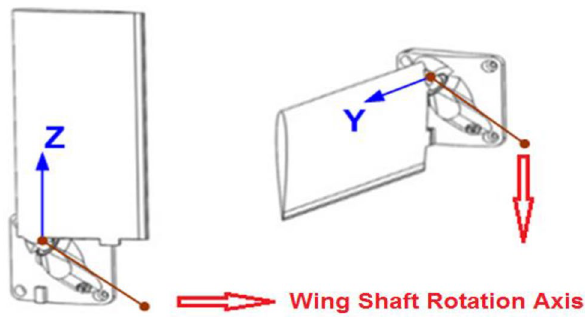
Figure 1. Folded and deployed positions of the missile wing from left to